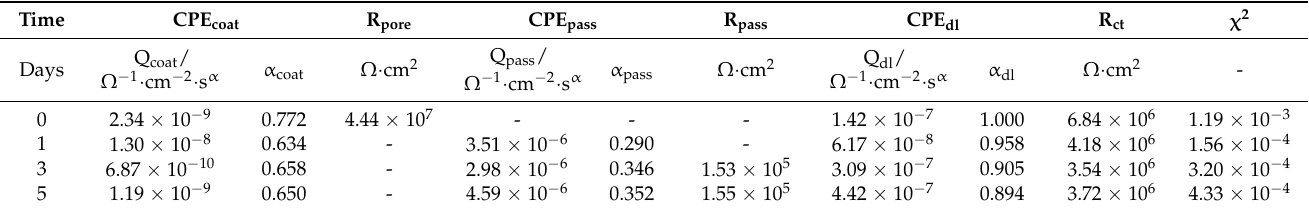
Table 6. Fitted values of EEC components, ZP 2% in EB